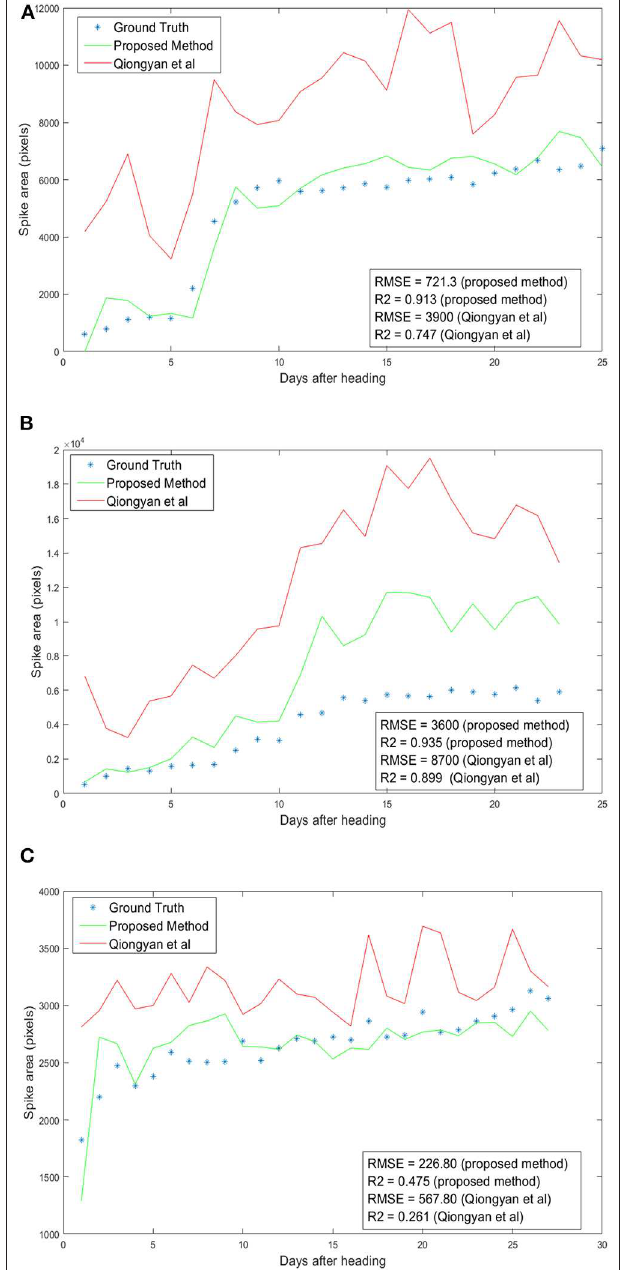
FIGURE 9 | Spike growth analysis: Day number 1 represents the first day of ear emergence in the wheat plants. (A) Plant ID 1817KN374 with multiple spikes. (B) Plant ID 1817KN409 with multiple spikes. (C) Plant ID 1817KN422 with a single spike.